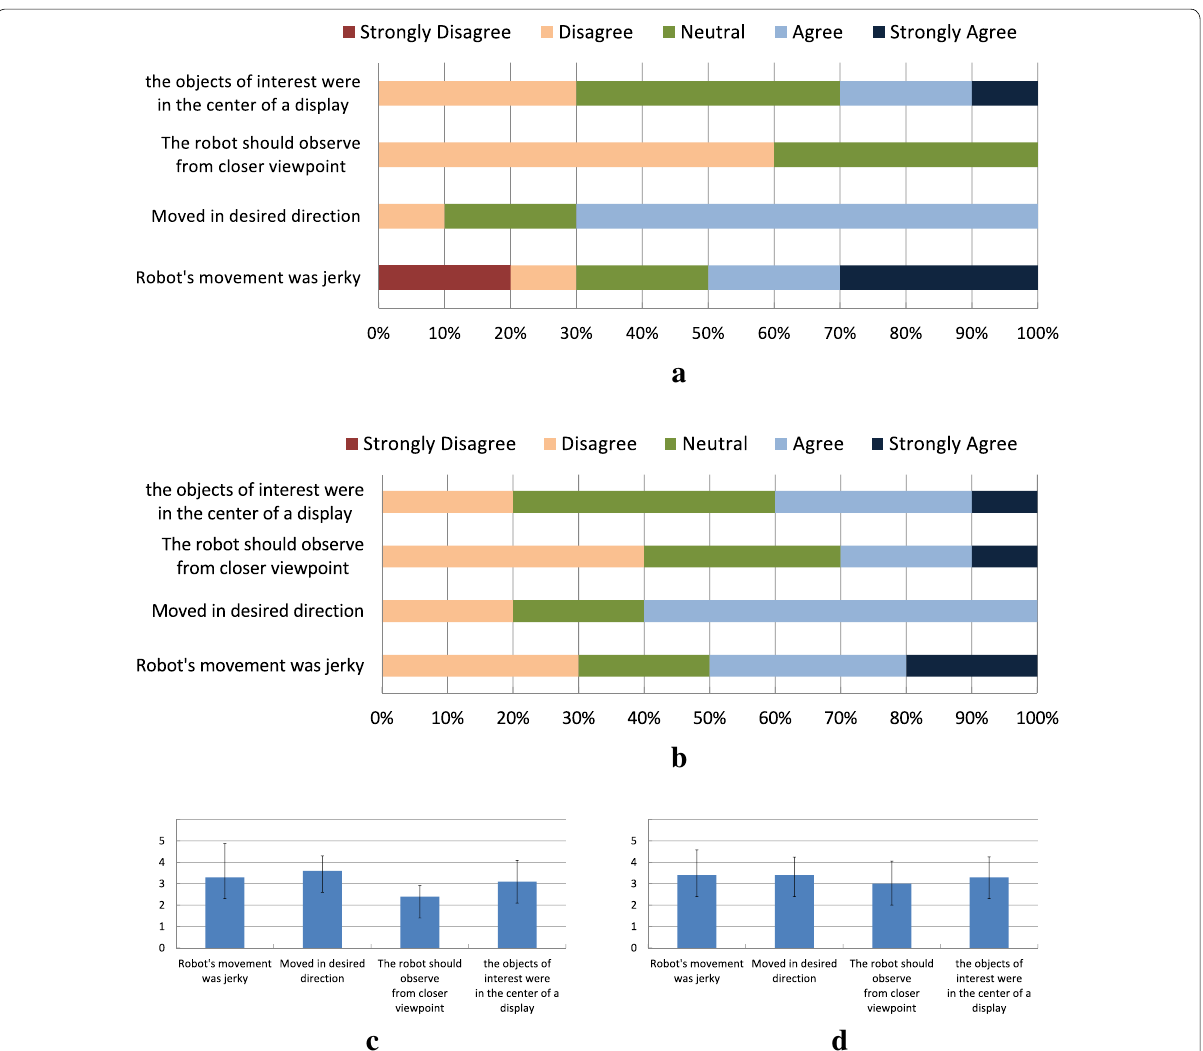
Fig. 20 Survey results on the evaluation of Local View Monitoring Robot’s movement. a Response frequency for navigation, b response frequency for Peg‑in‑Hole task, c average score for navigation, d average score for Peg‑in‑Hole